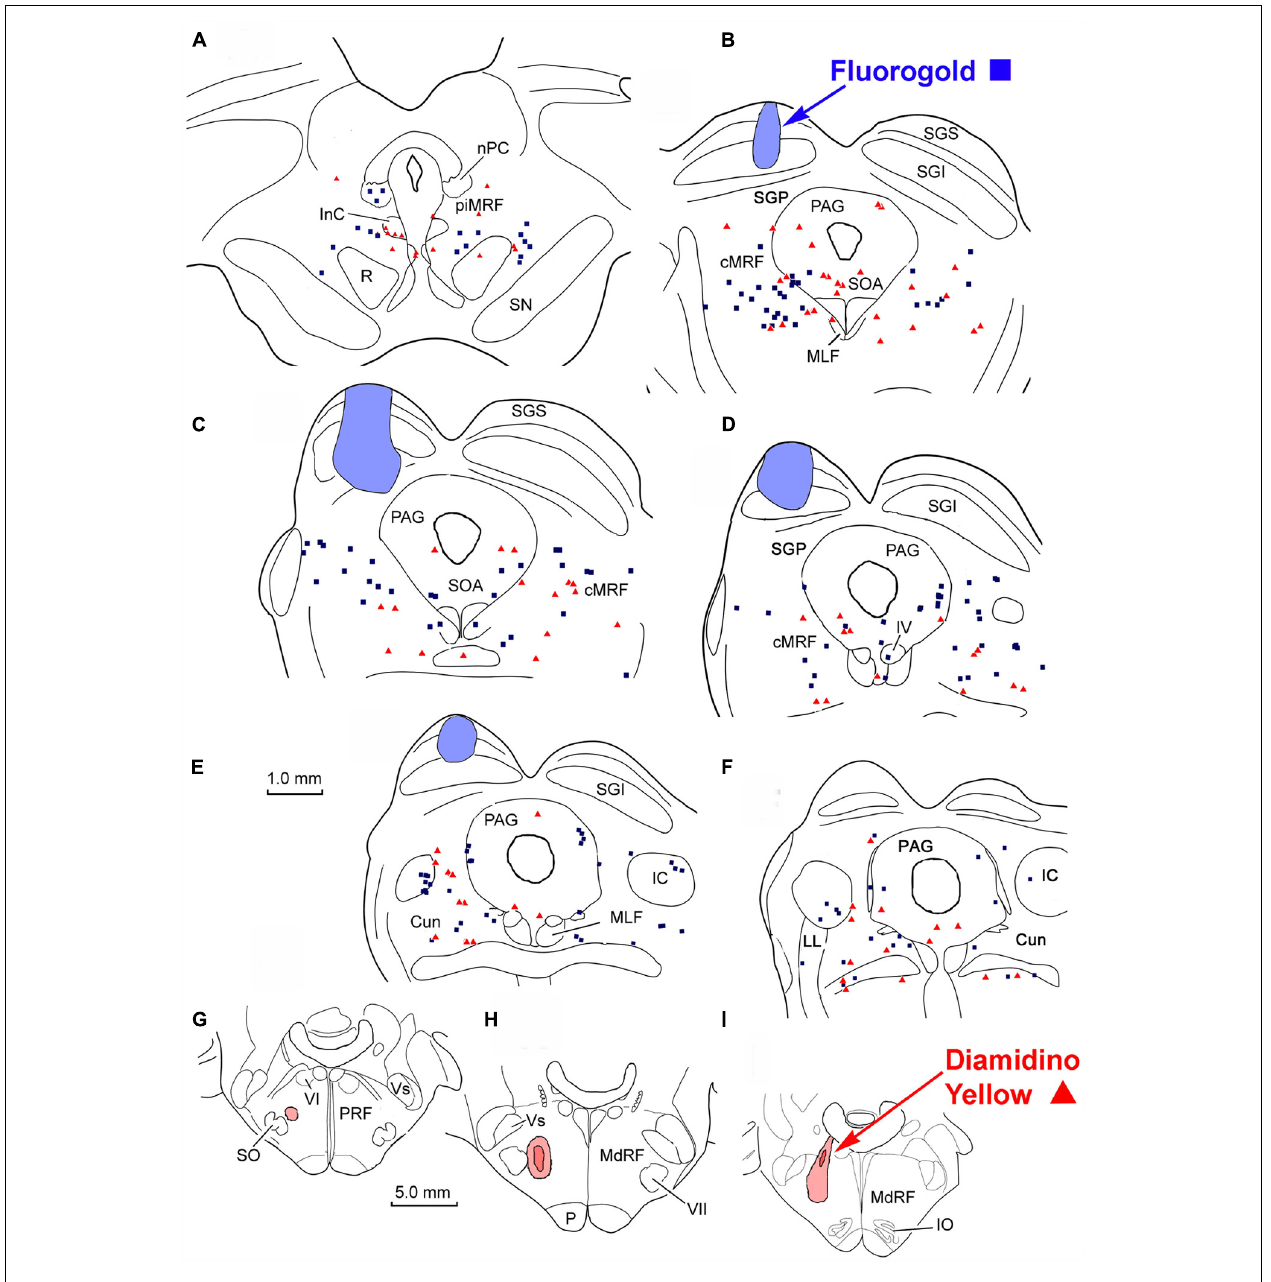
FIGURE 7 | Distribution of labeled reticulotectal neurons (cid:2) and medullary reticuloreticular neurons (cid:3) in MRF (A–F) produced by a FG injection in the SC (A–E) and a DY injection into the lateral MdRF (G–I).